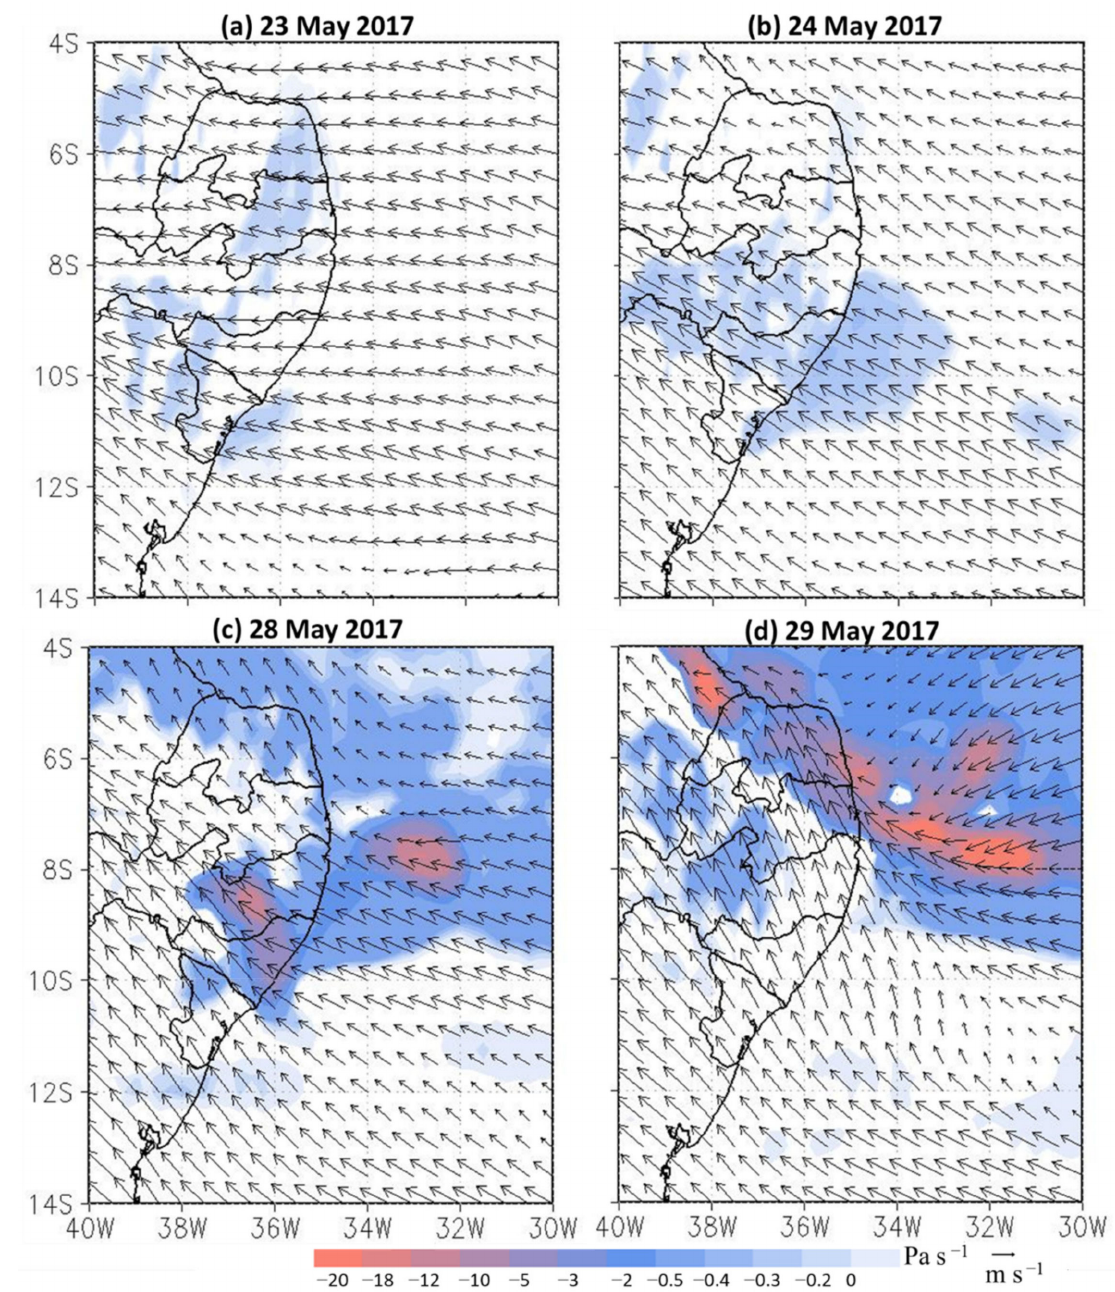
Figure 11. Average daily fields of vertical speed (shaded) at the vertical level of 700 hPa (Pa s − 1 ) and average wind flow in the current line at the level of 850 hPa (m s − 1 ). The information corresponds to 24 ( a ), 25 ( b ), 28 ( c ), and 29 ( d ) May